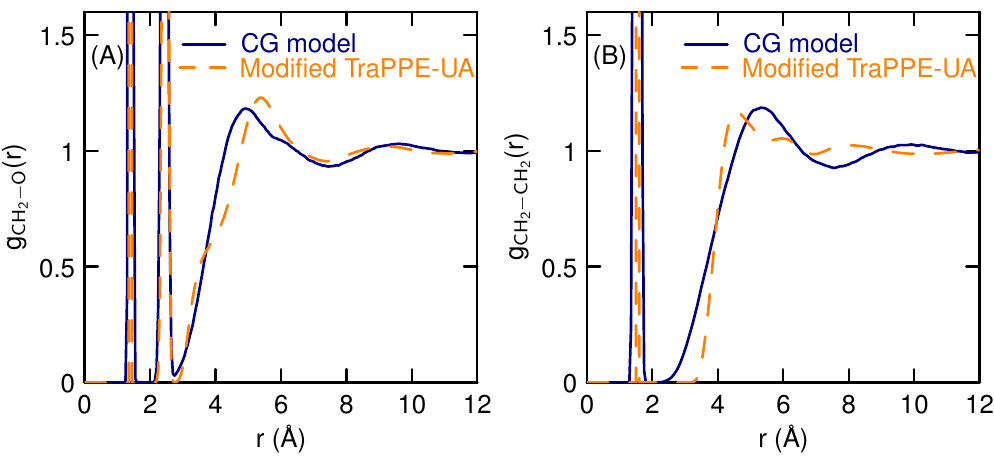
Figure 3. Liquid DME ( A ) oxygen-carbon ( B ) carbon-carbon radial distribution functions.